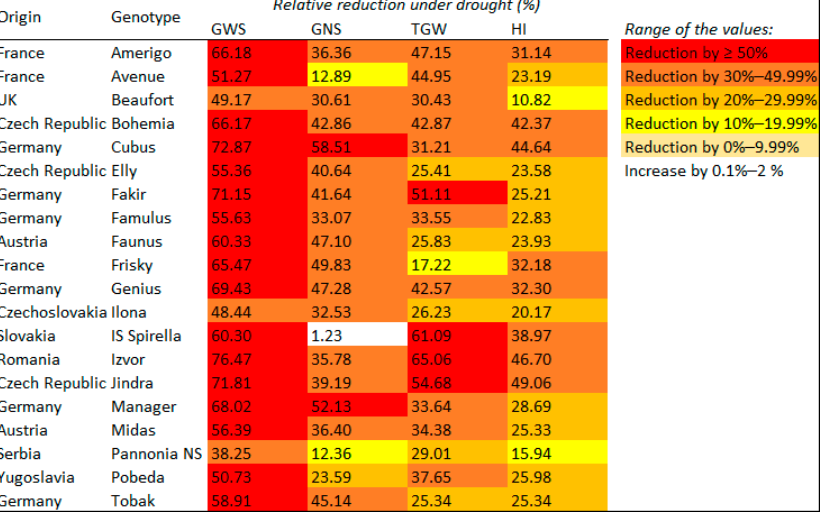
Figure 3. Drought-induced relative reductions (%) in GWS, GNS, TGW, and HI per